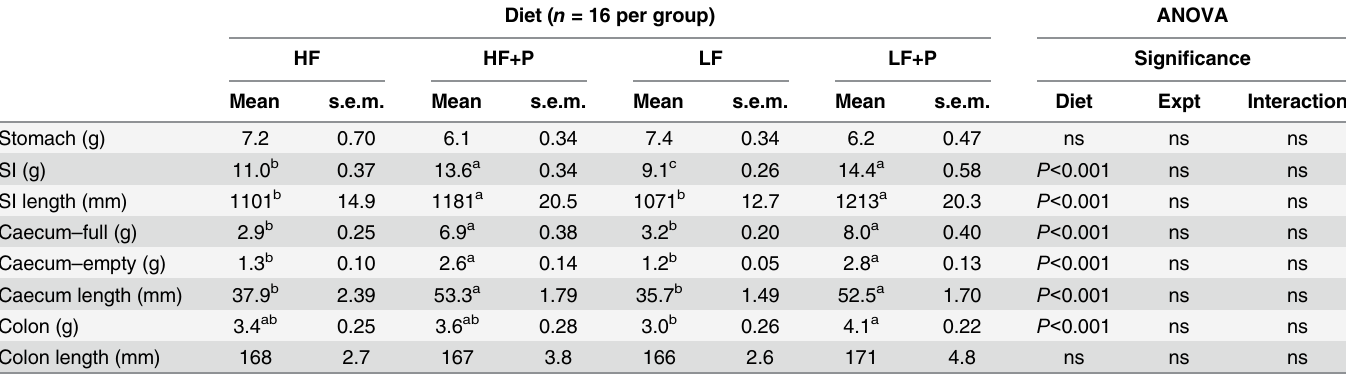
Table 3. Gut morphology. Final gut regional weight and lengths in diet-induced obese rats fed high fat diet (HF), high fat diet with 10% w/w pectin (HF+P), low fat diet (LF) or low fat diet with 10% w/w pectin (LF+P) for 4 weeks in two independently replicated experiments. Within rows, means with different super- script letters are significantly different (by ANOVA followed by Tukey ’ s post hoc